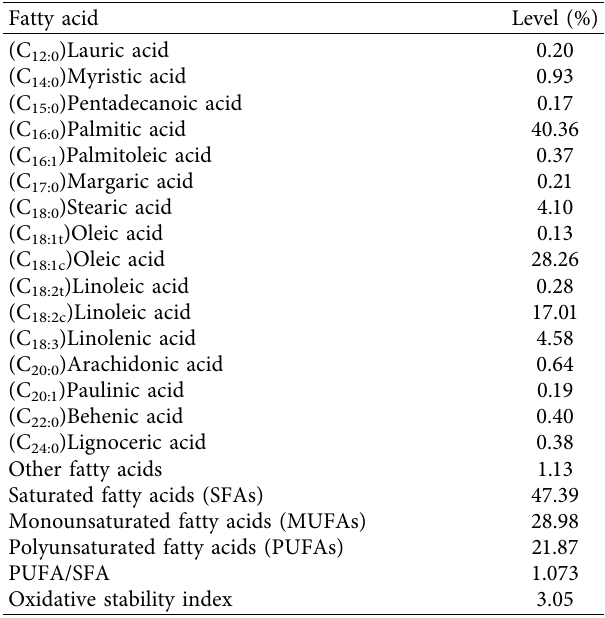
Table 1: Fatty acid profiles of the methanolic extract of C. dactylon